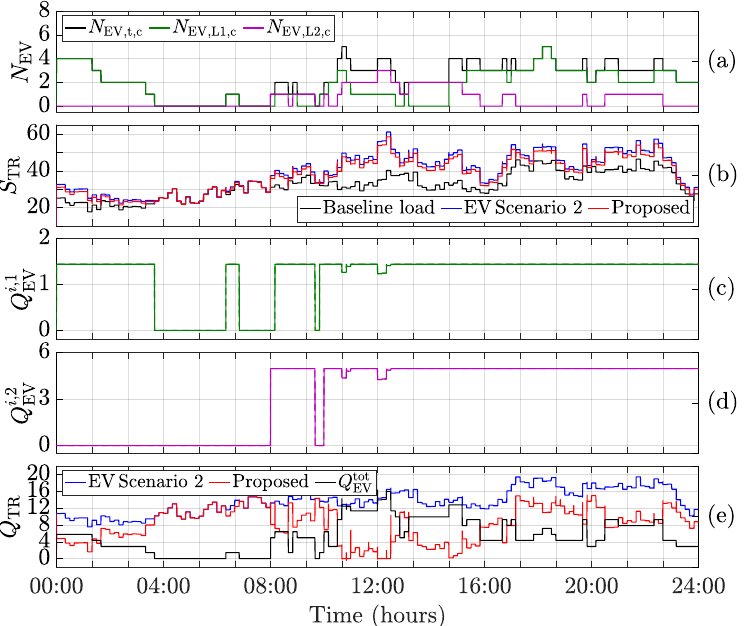
Figure 10. Scenario 2: combined Level 1 and Level 2, ( a ) number of EVs present; ( b ) transformer apparent power in kVA; ( c ) Q supplied by an online EV at Level 1 in kVAr; ( d ) Q supplied by an online EV at Level 2 in kVAr; ( e ) transformer reactive power in kVAr.